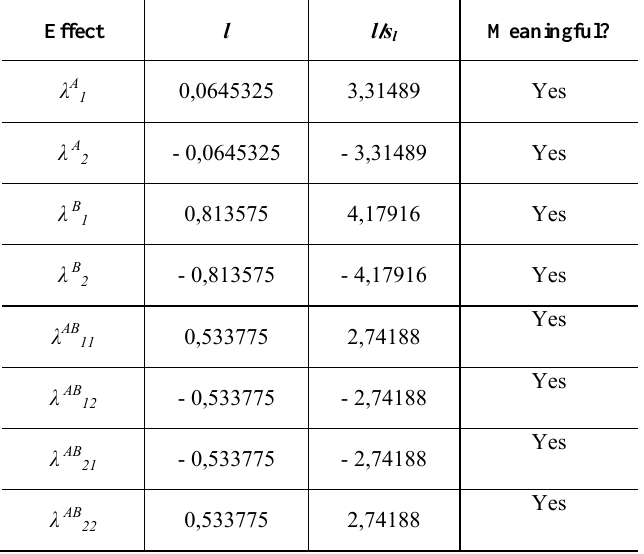
Table 2: Estimated λ -effects, standard deviations of l - estimations and standardised l -values for the log linear analysis of the satisfied